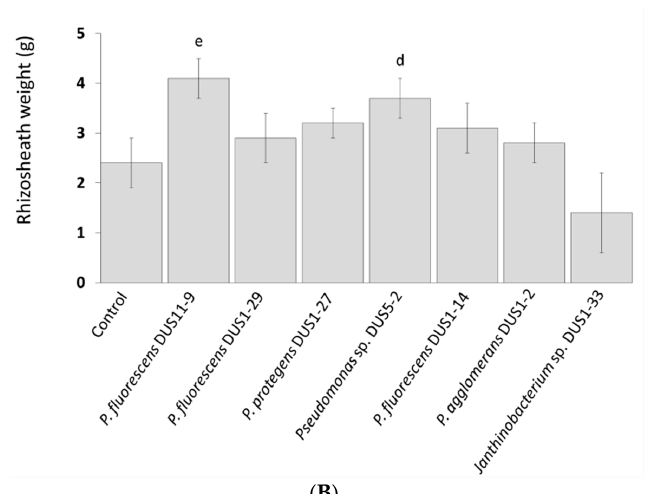
Figure 6. Effect of bacterial isolates on rhizosheath mass for plants growth in 8% ( A ) or 4% ( B ) water activity after 91 days of growth in a glasshouse system in the presence of plant growth promoting (PGP) bacterial strains (control plants were uninoculated). For inoculated plants, 1 × 10 3 CFU of each strain were added when seeds were sown. Five biological replicates (five pots) with five technical replicates (five plants per pot) were set up and grown for 91 days for each treatment group. For rhizosheath mass from plants grown in 8% water activity: “a” denotes significant ( p < 0.05) difference between rhizosheath of plants inoculated with Janthinobacterium sp. DUS1-33 compared to control plants rhizosheath. “b” denotes significant ( p < 0.05) difference between P. fluorescens DUS11-9 and DUS1-29 compared to rhizosheaths of uninoculated control plants, or plants inoculated with Pseudomonas sp. DUS5-2, P. fluorescens DUS1-14, or P. agglomerans DUS1-2. “c” denotes significant ( p < 0.05) difference between P. protegens DUS1-27 with rhizosheaths from all other treatments apart from P. fluorescens DUS1-29. For rhizosheath mass from plants grown in 4% water activity: “d” denotes significant ( p < 0.05) difference between rhizosheaths of plants inoculated with Pseudomonas sp. DUS5-2 compared to uninoculated control plants and plants inoculated with Janthinobacterium sp. DUS1-33. “e” denotes significant ( p < 0.05) difference between rhizosheaths of plants inoculated with P. fluorescens DUS11-9 compared to uninoculated control plants and plants inoculated with Pseudomonas strains DUS1-29 and DUS1-27, P. agglomerans DUS1-2, or Janthinobacterium sp. DUS1-33. For both 8% and 4% water activity treatment groups, there was no significant difference ( p > 0.05) in germination rate observed after seven days for control or inoculated seeds, with germination rates of 97% to 100% (Tables 4 and 5).